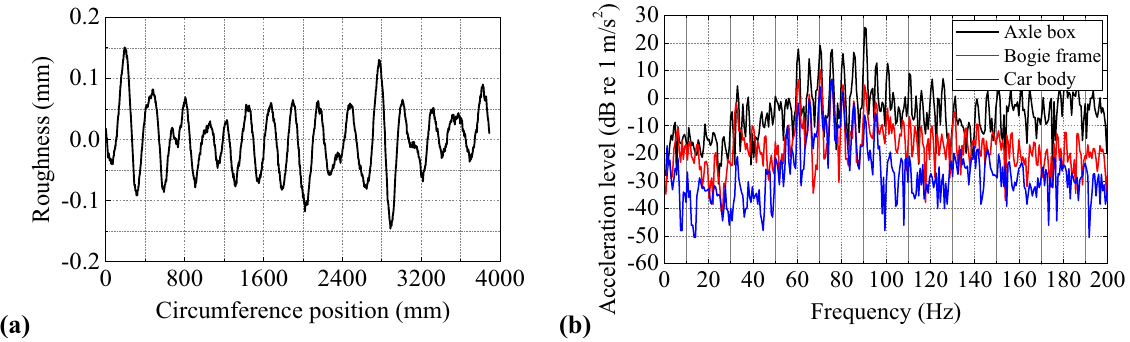
Fig. 9 Polygonisation-induced vibration of locomotive [34]: a wheel polygonal wear measurement results and b vertical acceleration spectra of the axle box, bogie frame, and car body of